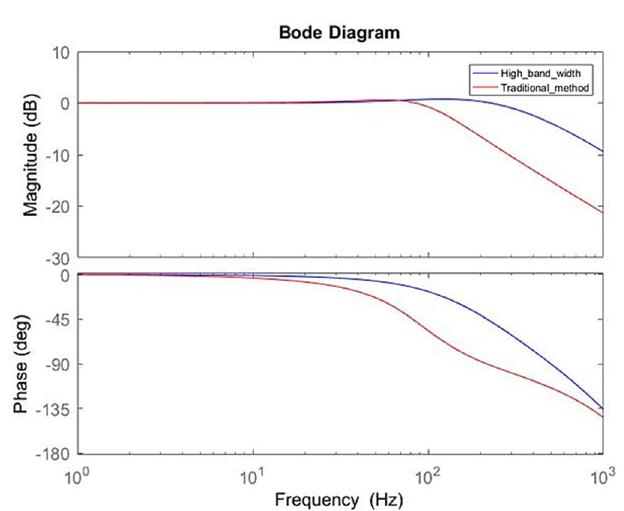
Figure 10. Bode diagram of current loop.